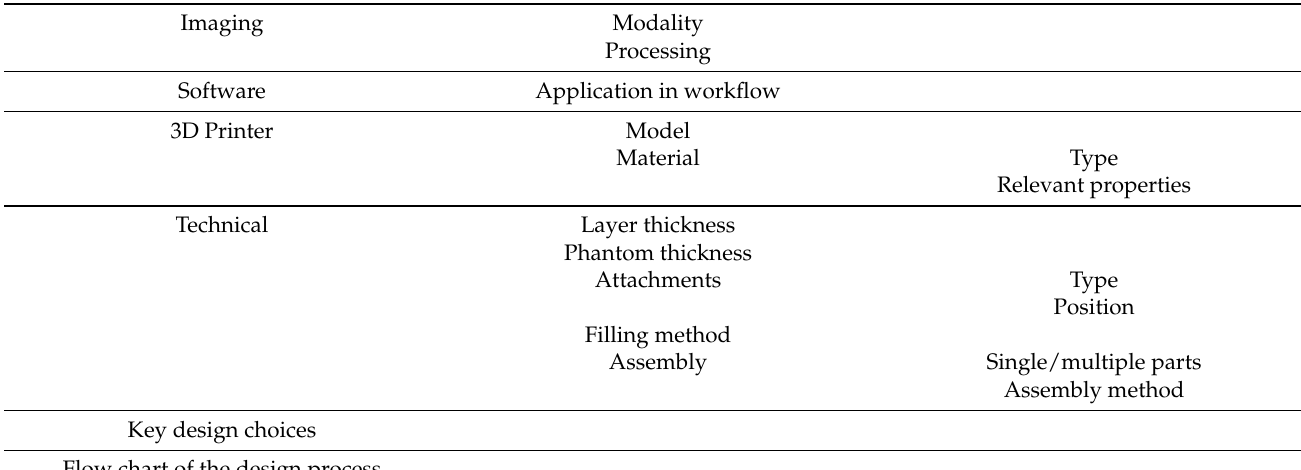
Table 2. Examples of information which should be included in future publications of 3D-printed